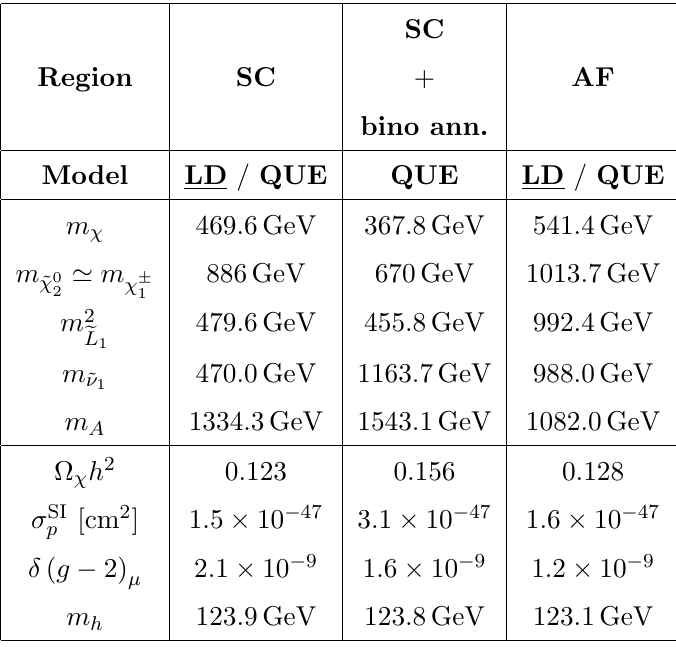
Table 3. Benchmark points for regions with the correct value of the DM relic density: the slepton- coannihilation (SC), A -funnel (AF) and a region of slepton-coannihilation with additional e(cid:14)cient bino annihilation into 4 th generation leptons (SC+bino ann.). The model in which a given region is present in the favored parameter space is also denoted. In case of regions present in both models the underline indicates the model from which the benchmark point was taken. Note that the second benchmark point is most probably excluded by 3-lepton